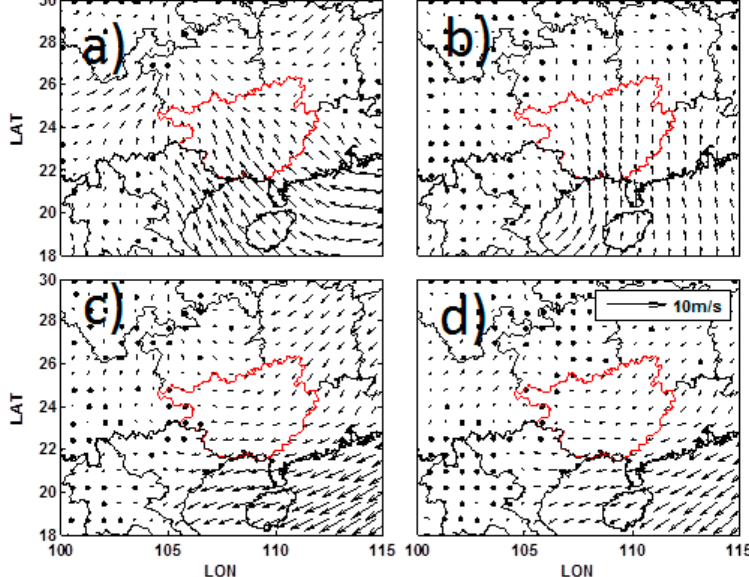
Figure 12. Monthly winds at 950 hPa in 2014 based on ECMWF. ( a ) April; ( b ) July; ( c ) October; ( d ) January. (The red line indicates the GX border).